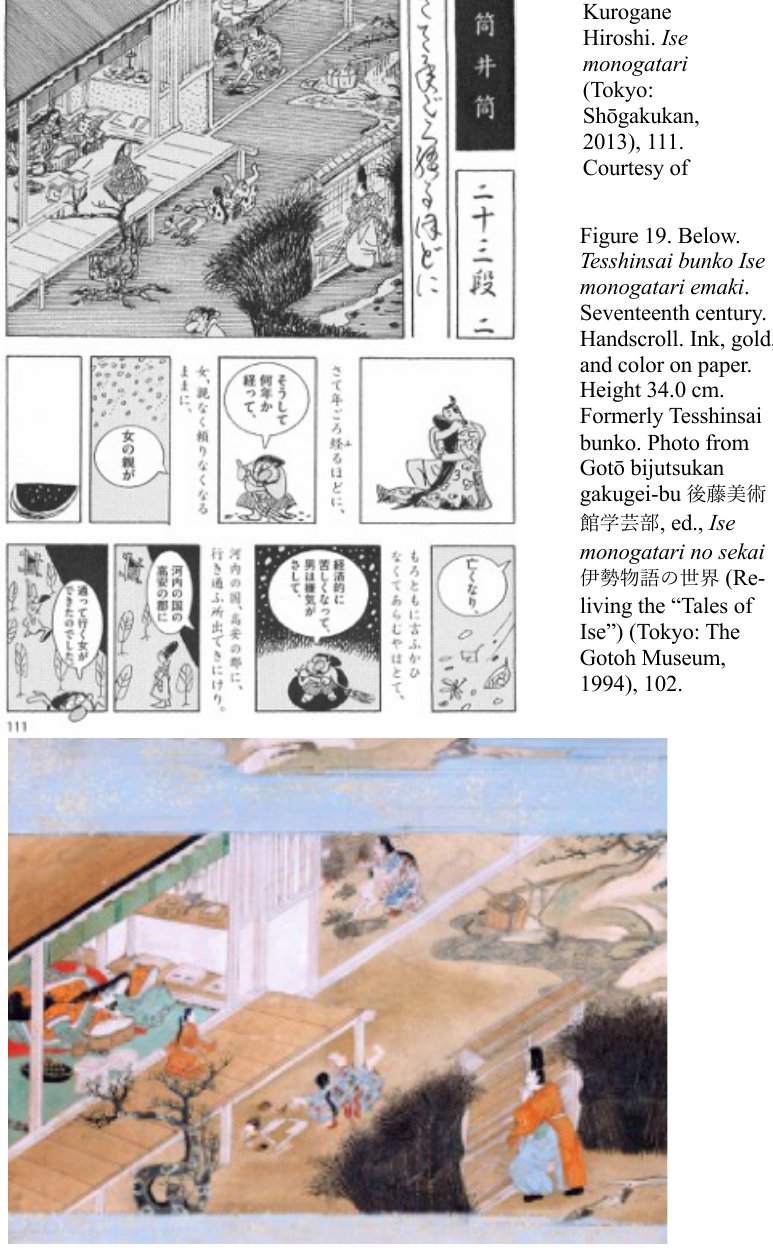
Courtesy of Figure 19. Below. Tesshinsai bunko Ise monogatari emaki . Seventeenth century. Height 34.0 cm. bunko. Photo